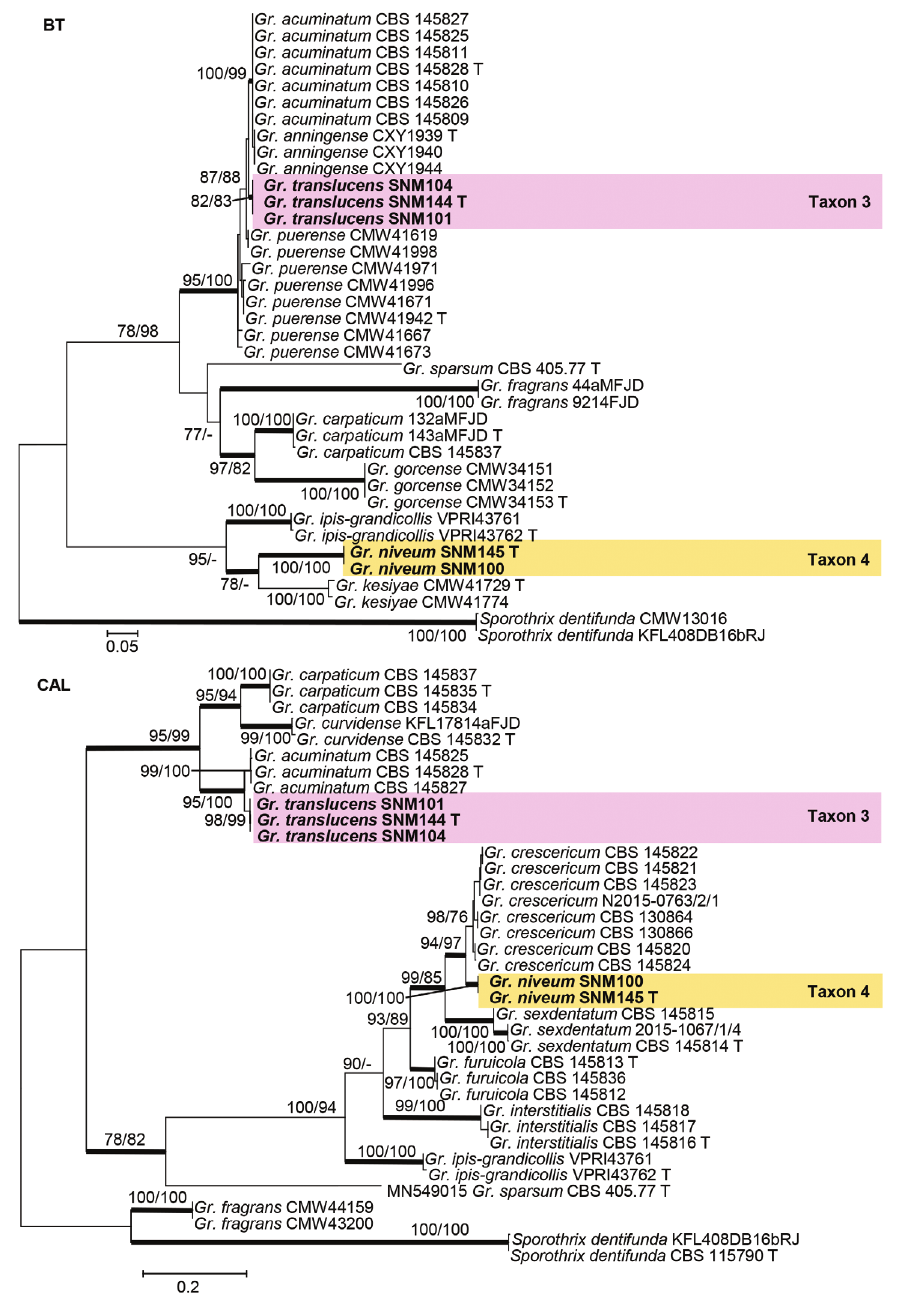
Figure 4. Maximum likelihood phylogeny of Graphilbum using partial BT and partial CAL gene regions. The isolates recovered in this study are highlighted in color and in bold font. ML and MP bootstrap support values ≥ 75 are indicated at the nodes as ML/MP. Bold branches indicate posterior probabilities values ≥ 0.9. T indicates ex-type